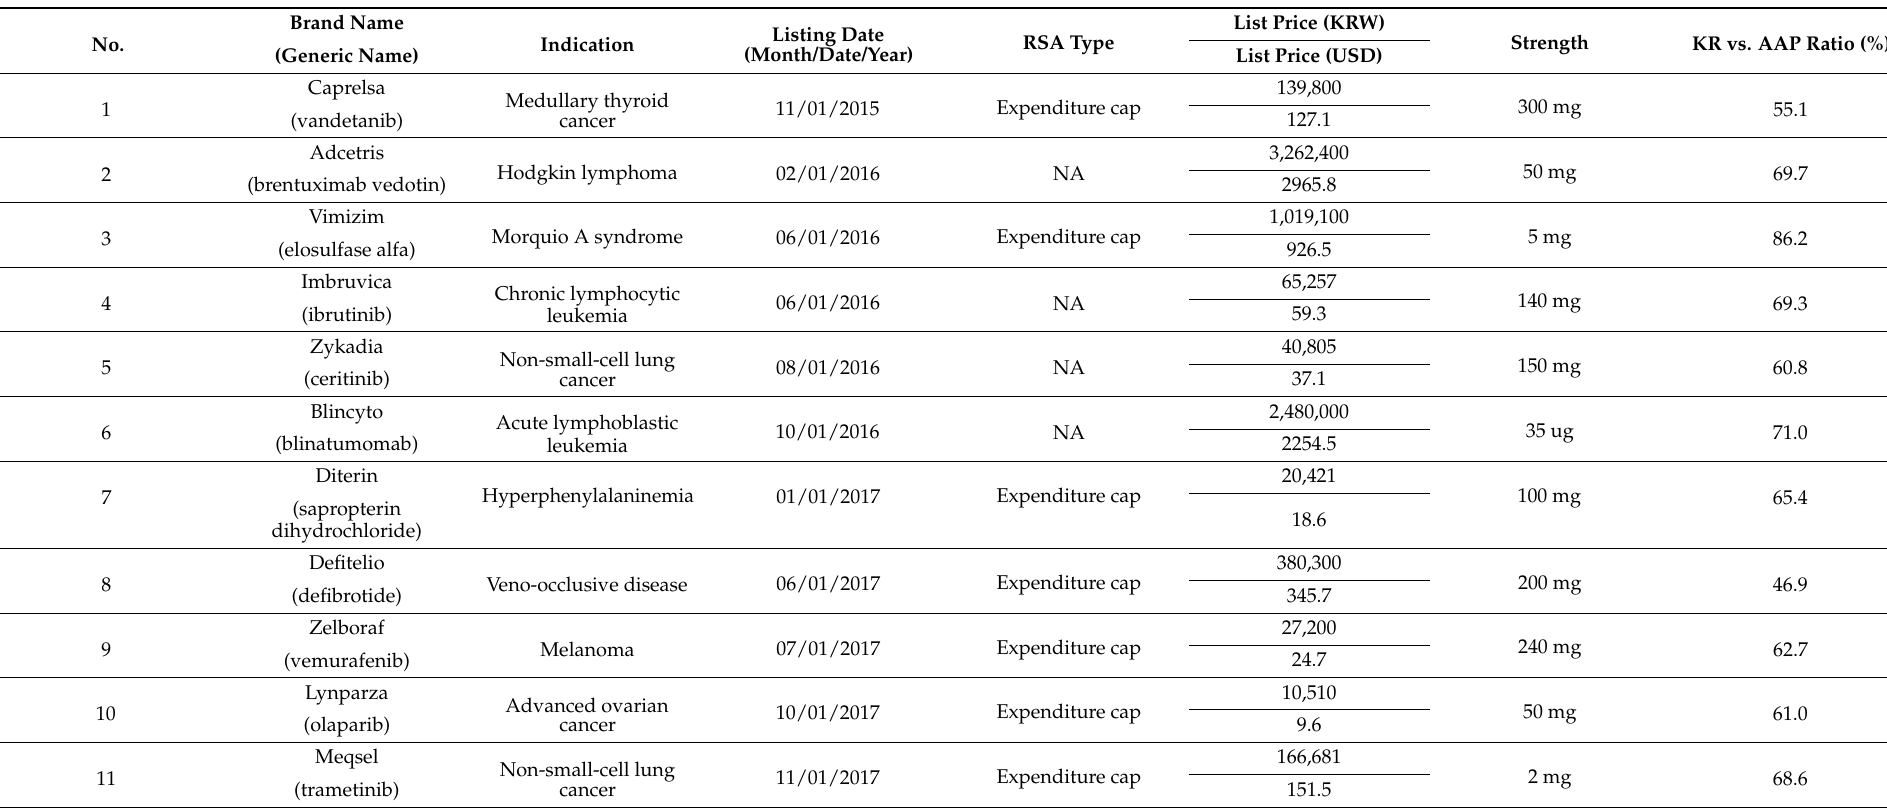
Table 3. New orphan drugs evaluated as pharmacoeconomic evaluation (PE) waiver pathway in South Korea (listed during the period January 2007–March 2017).